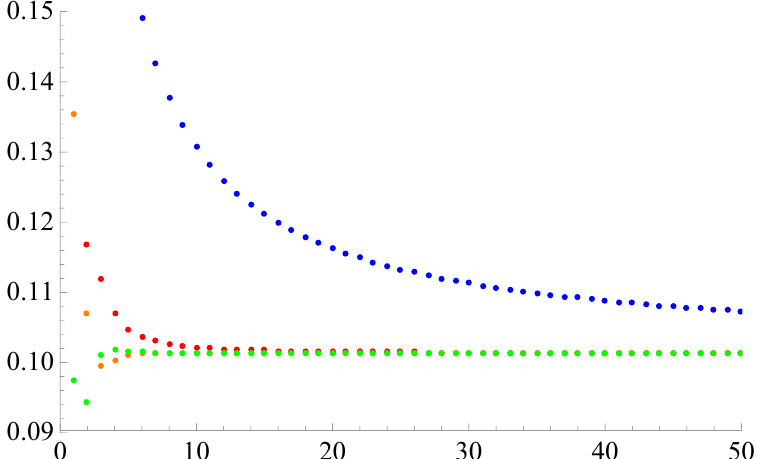
Figure 2 . In this figure, we show the ratio a k +1 blue line represents the original ratio, while the red, orange, and green lines denote, respectively, the first three Richardson extrapolations. The ratio tends to the value 1